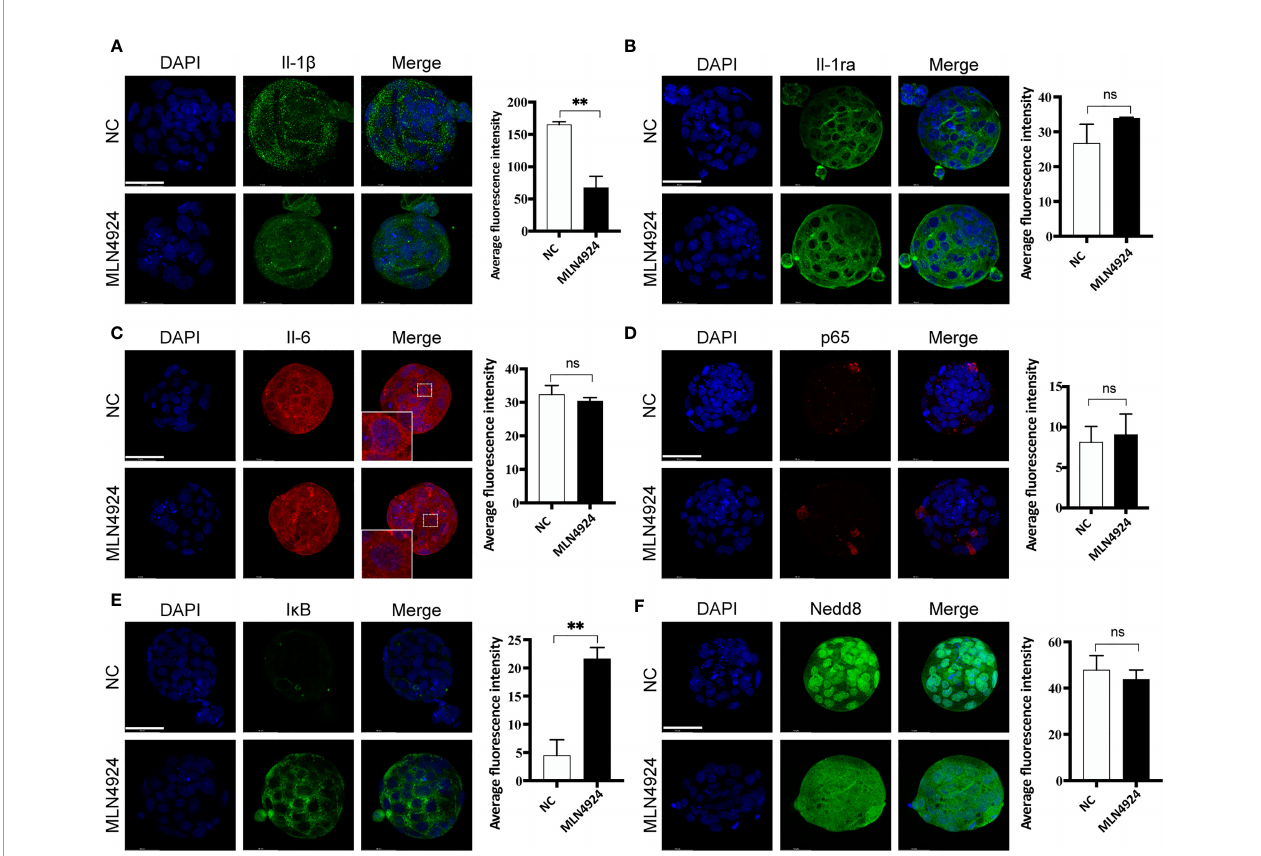
FIGURE 4 | Secreted IL-1 b reduced in an NF- k B-independent manner after neddylation inhibition. (A) Immuno fl uorescence of IL-1 b (green) in NC (n = 30) and the MLN4924-treated blastocysts (n = 30). DPAI-labeled DNA is shown in blue. The fl uorescence signal intensities were decreased in MLN4924-treated blastocysts compared with NC. (B) Representative images of IL-1ra (green) from NC (n = 30) and the MLN4924-treated groups (n = 30). No signi fi cant difference in fl uorescence intensity between the two groups. (C) Immuno fl uorescence of IL-6 (red) in NC (n = 30) and the MLN4924-treated groups (n = 30). The intensity of the two groups showed no signi fi cant difference. (D) Immuno fl uorescence of p65 (red) in NC (n = 30) and the MLN4924-treated blastocysts (n = 30). The fl uorescence signal intensities showed no signi fi cant difference in MLN4924-treated blastocysts compared with NC. (E) Immuno fl uorescence of I k B (green), a member of the NF- k B signal pathway, in NC (n = 30) and the MLN4924-treated blastocysts (n = 30), showing signi fi cant accumulation in the MLN4924-treated group. (F) Immuno fl uorescence of Nedd8 (green) in NC (n = 30) and the MLN4924-treated blastocysts (n = 30). Compared with the nuclear localization of Nedd8 in NC group, blastocysts treated with MLN4924 lost the original cellular localization and diffused into the